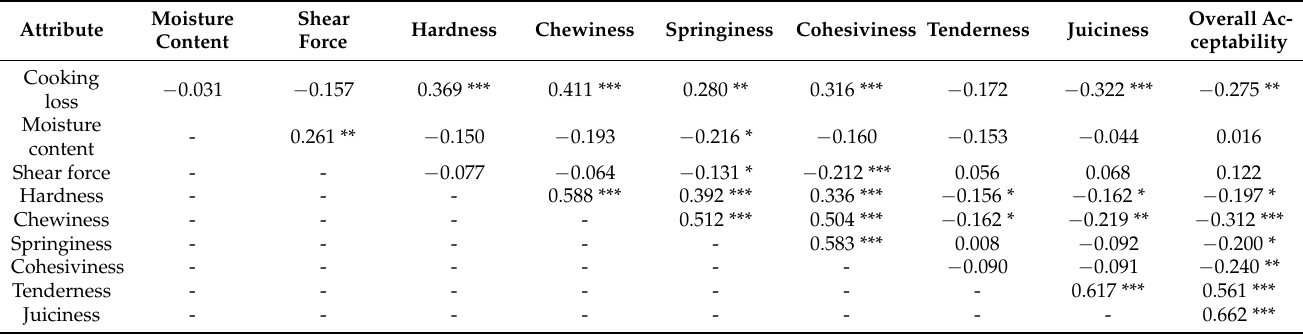
Table 6. Correlation coefficients between selected attributes of sous vide cooked pork